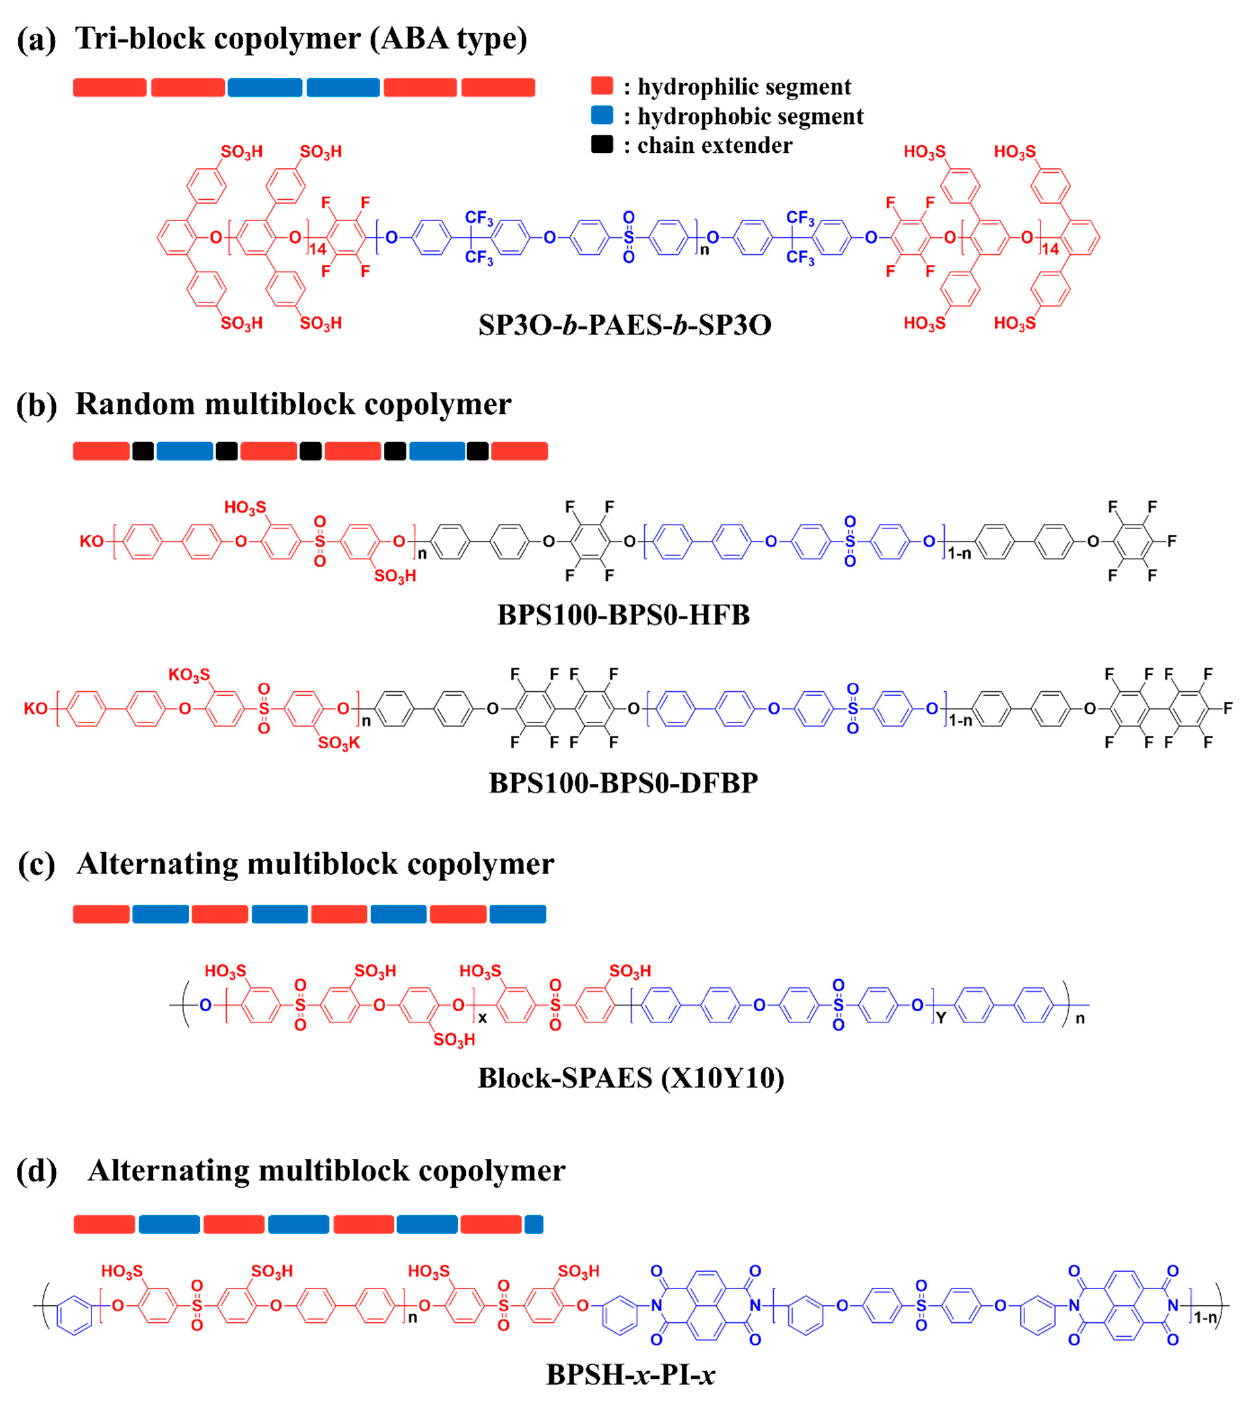
Figure 4. Representative chemical structures of sulfonated hydrocarbon-based block copolymers [63,64,67,68].